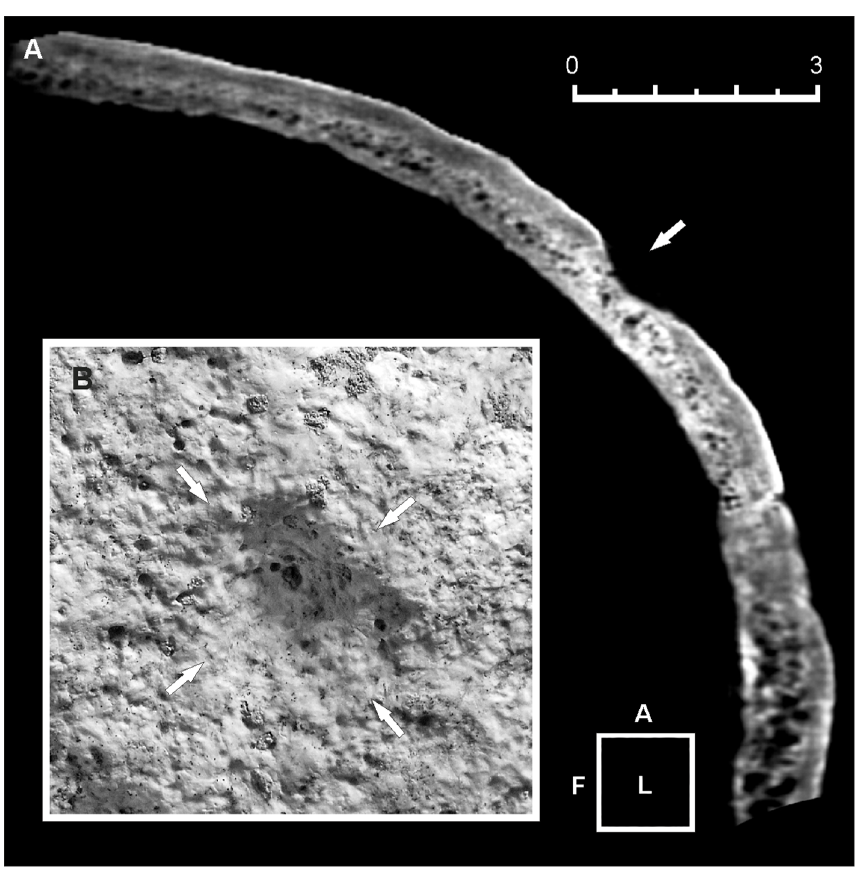
Fig 5. Three-dimensional (3D) computed tomography (CT) scan of the minor skull trephination. (A, B) Sagittal plane CT scan (A). Only the external cortical layer of the bone is affected (arrow). Detail of the cone- shaped lesion, identified as an incomplete trephination with a possible ritual purpose (B). Bone remodeling, hypervascularity and pitting of the ectocranial surface suggest an advanced phase of the bone healing process. Scale bar measures 3